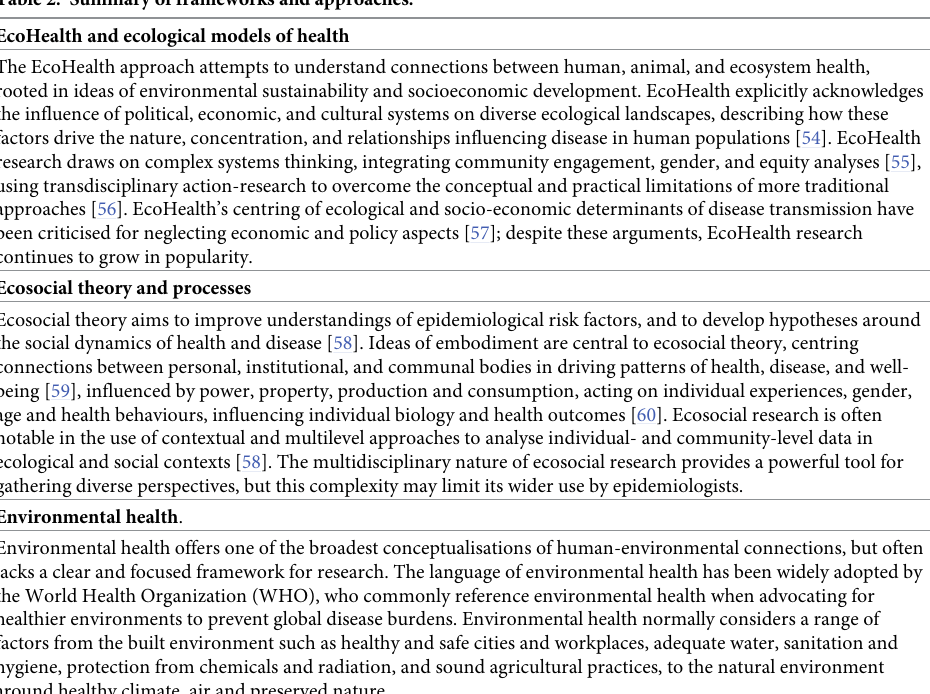
Table 2. Summary of frameworks and